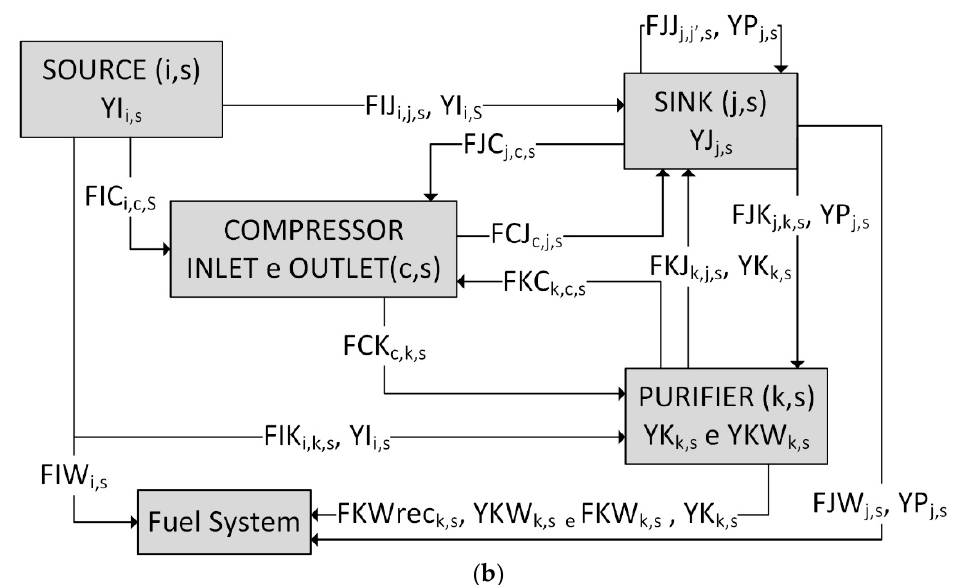
Figure 1. ( a ) Scheme of the Superstructure developed for the Mixed-Integer Linear Programming (MILP) problem. ( b ) Scheme of the Superstructure developed for the Mixed-Integer Nonlinear Programming (MINLP) problem.